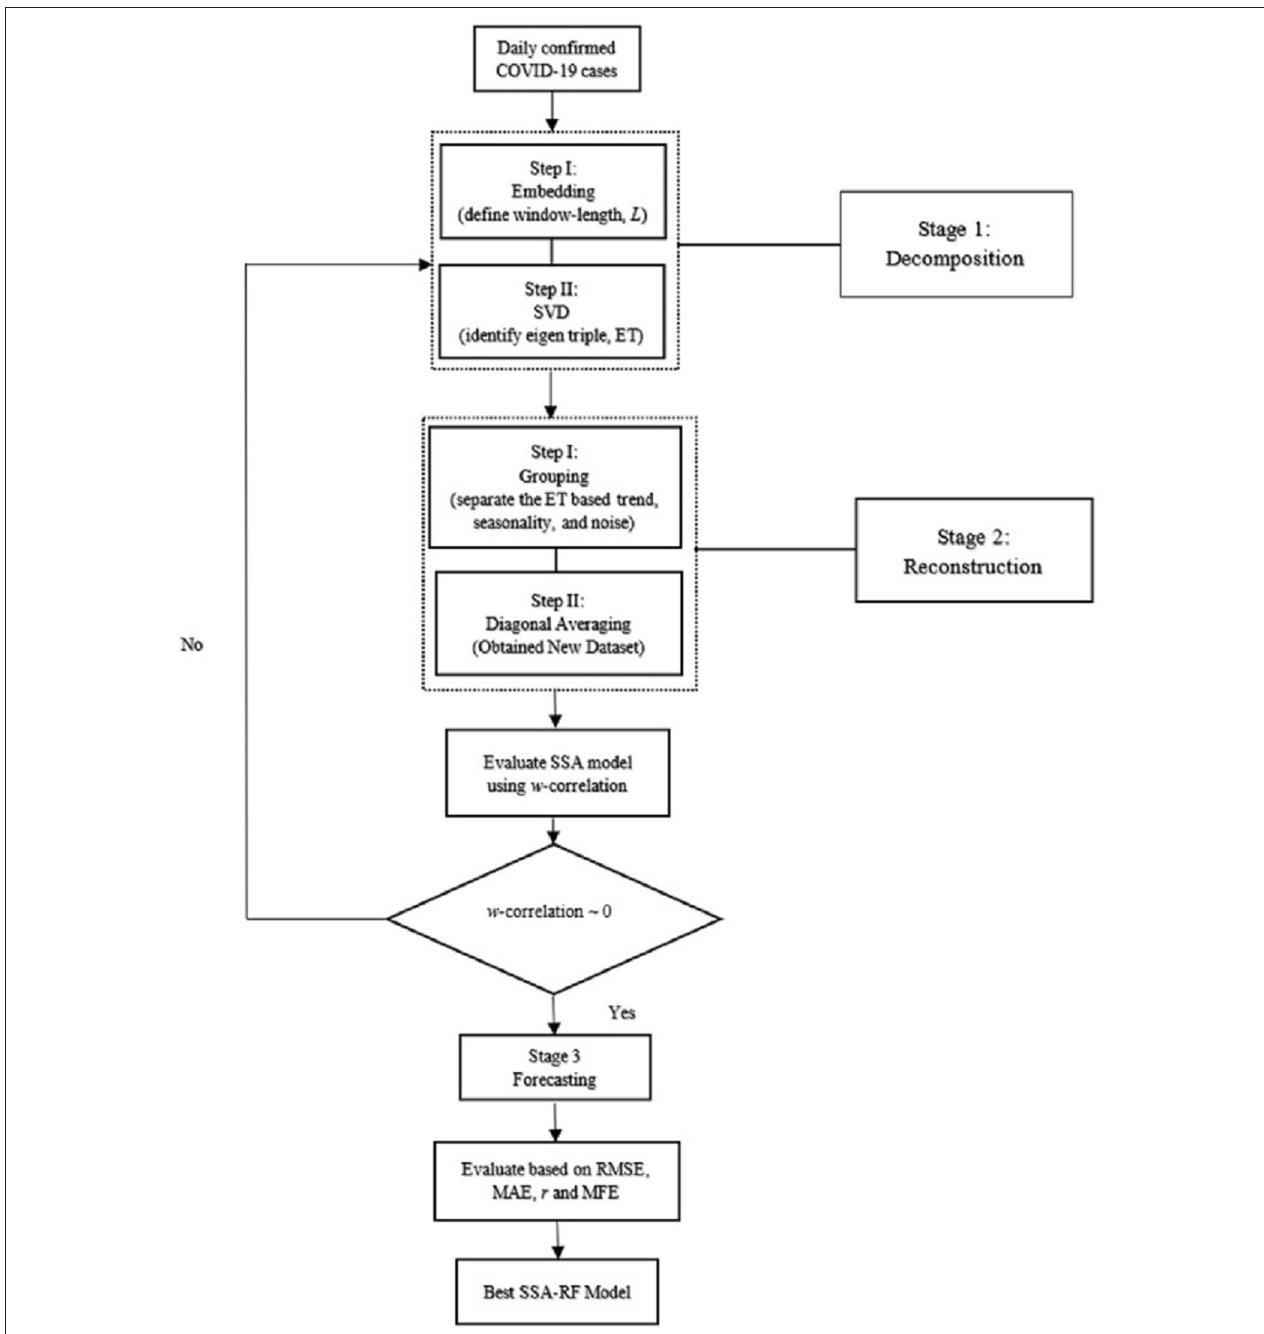
FIGURE 3 | Flow chart of developed forecasting, model of